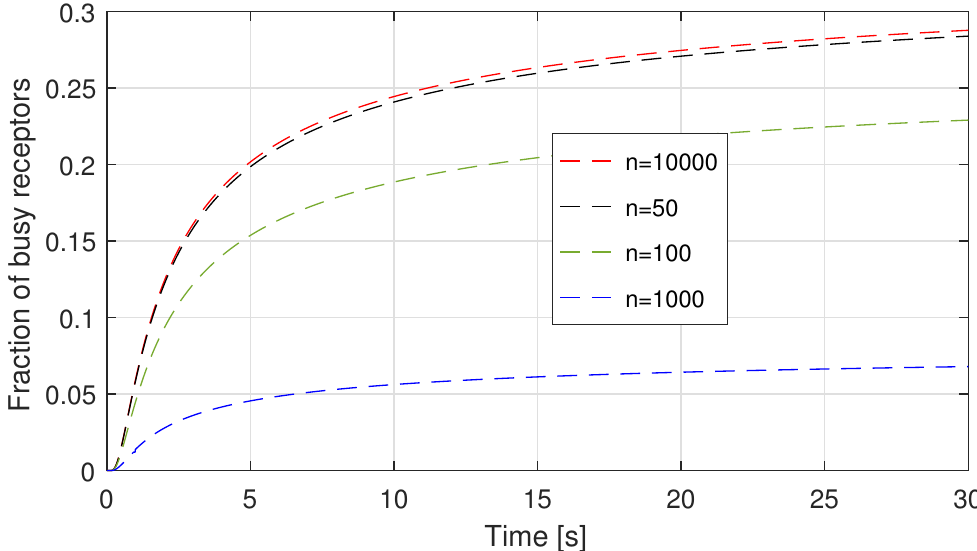
Figure 6. Average number of busy receptors as a function of time for different values of n